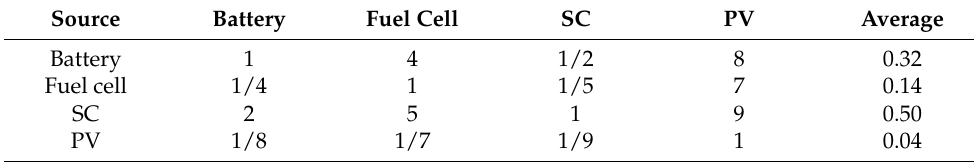
Table 3. Ease of charge relative scores.